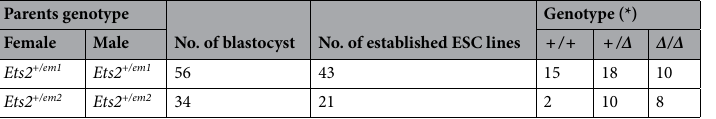
Table 3. Establishment of Ets2 Δ/Δ ESC lines from blastocysts. (*) em1 or em2 allele shown as